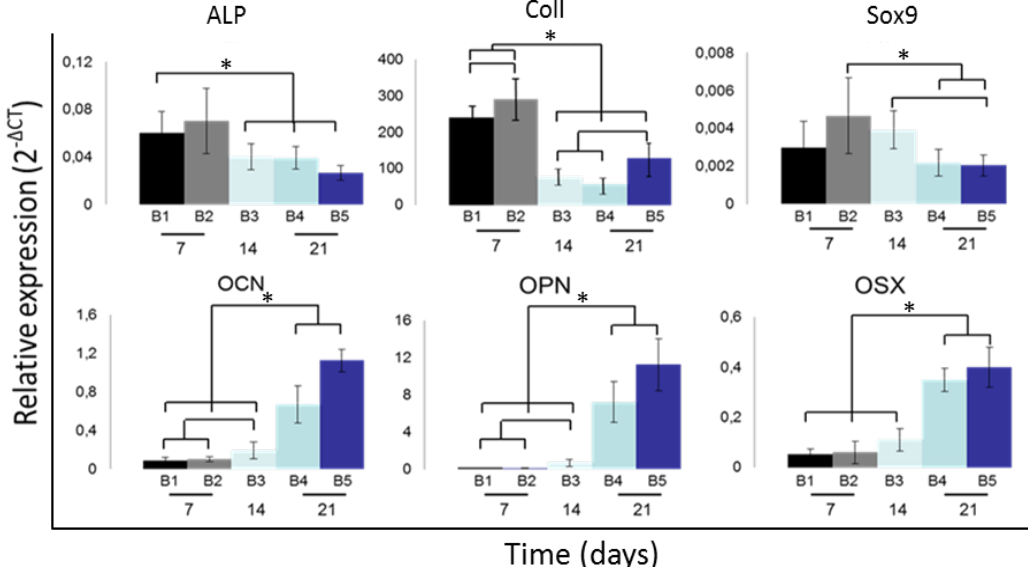
Figure 4. Gene expression data for hPDCs cultured in CaP-supplemented medium for all experimental conditions. Data shown are the relative expression of the gene of interest normalized to the HPRT1 housekeeping gene. This data set corresponds to the experimental design employed in this study, as shown in Table 1. Mean ± S.D. error of the mean ( n = 3). Unpaired t -test (two-tailed): * p < 0.05. ALP, alkaline phosphatase;